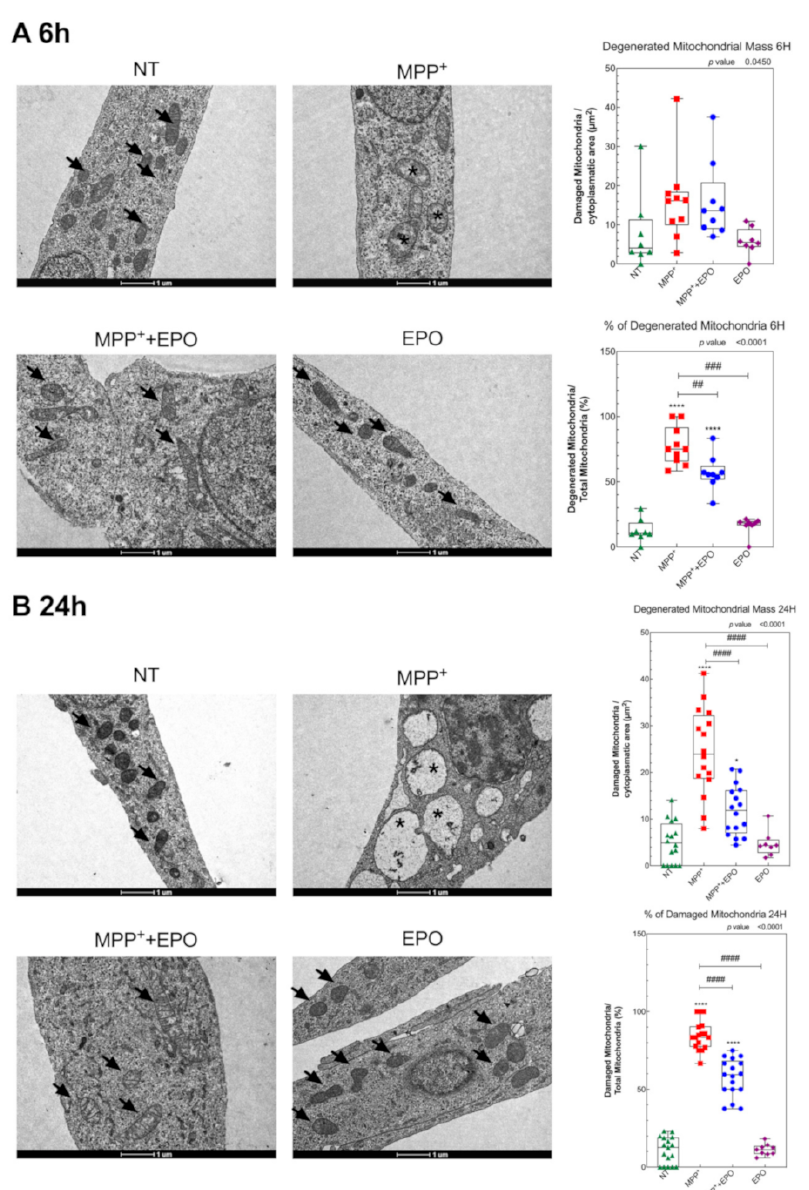
Figure 5. EPO promotes the preservation of mitochondria ultrastructure. Transmission electron microscopy micrographs showing a portion of cytoplasm of SH-SY5Y cells (NT), after 6 h ( A ) and 24 h (B) treatment with MPP + , MPP + + EPO or EPO. Arrows indicate healthy mitochondria and asterisks indicate mitochondria with strong signs of damage (disruption of cristae architecture and reduced matrix density). Scale bars = 1 µ m. Data reported in the histogram refer to the box and whisker plot of 8 area values in 1 experiment and results are represented as percent of NT. * p < 0.05, **** p < 0.0001 vs. NT; ## p < 0.01, ### p < 0.001, #### p < 0.0001 vs. MPP +